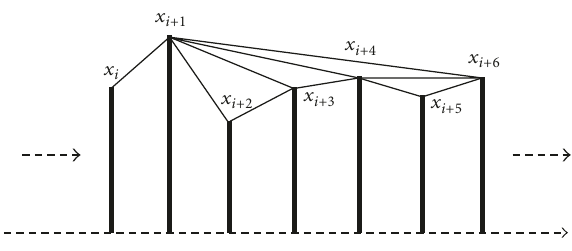
Figure 1: Visibility graph for time series 𝑋